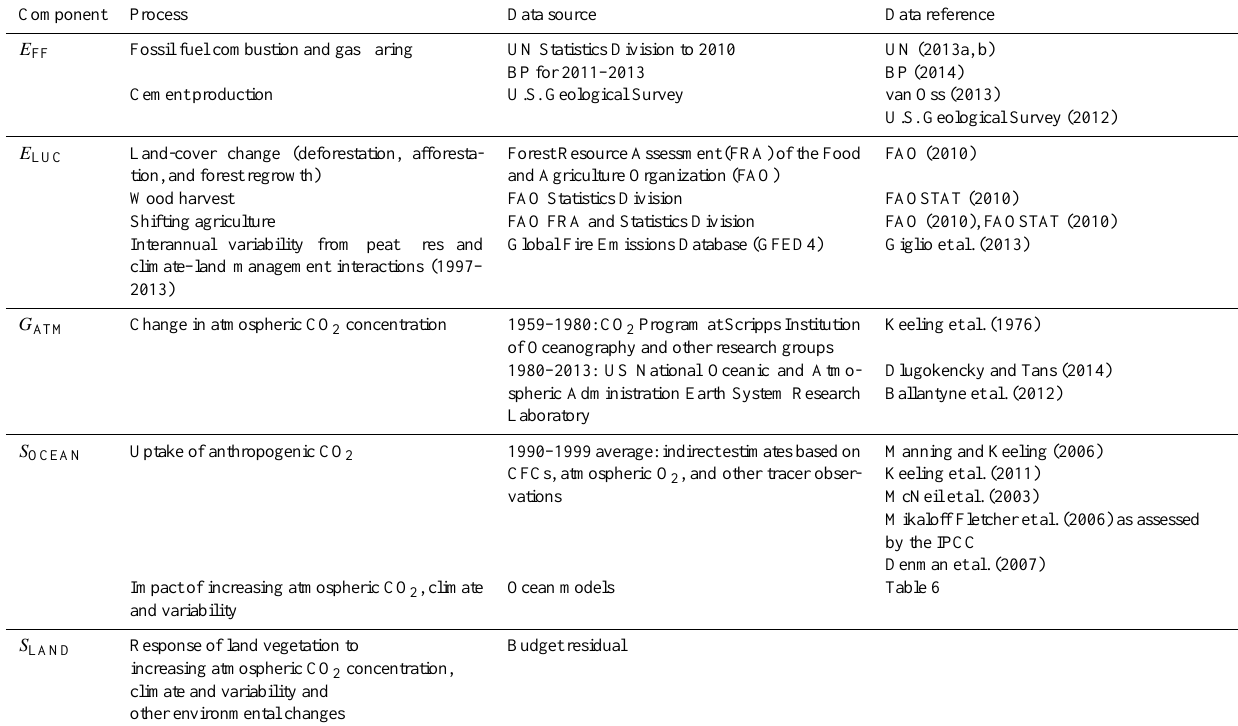
Table 4. Data sources used to compute each component of the global carbon